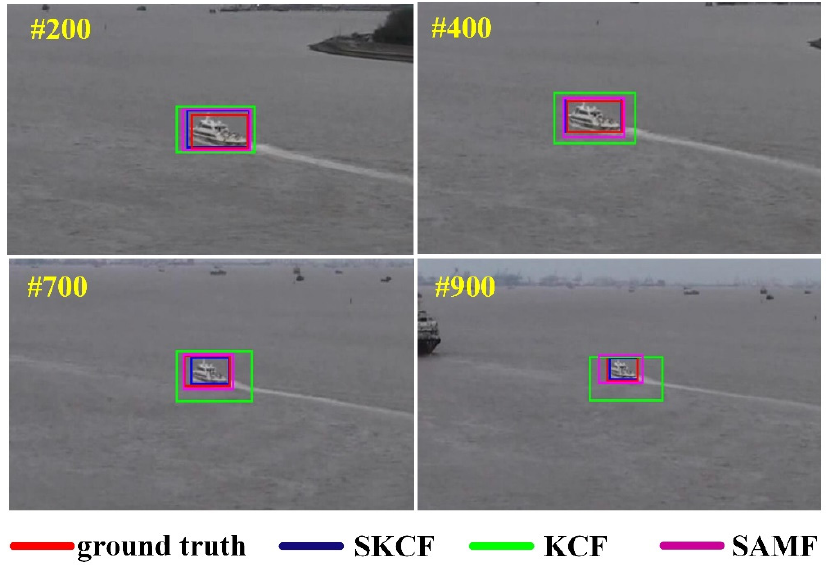
Figure 7. Ship tracker performance on typical frames for video